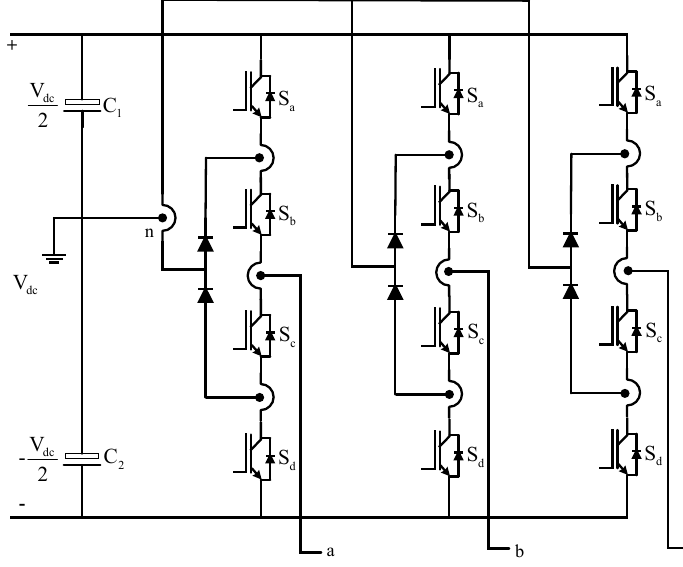
Figure 3. Three-level diode neutral-point clamped inverter.